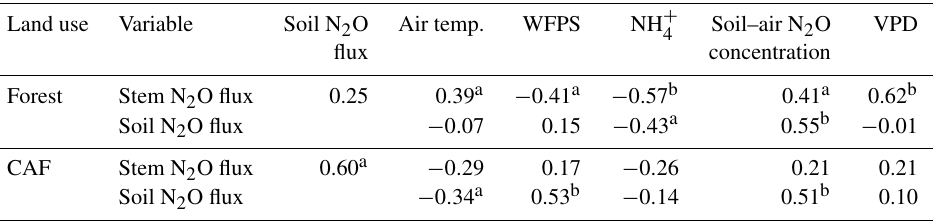
(mgNkg − 1 , top 5cm depth), soil–air N 2 O 4